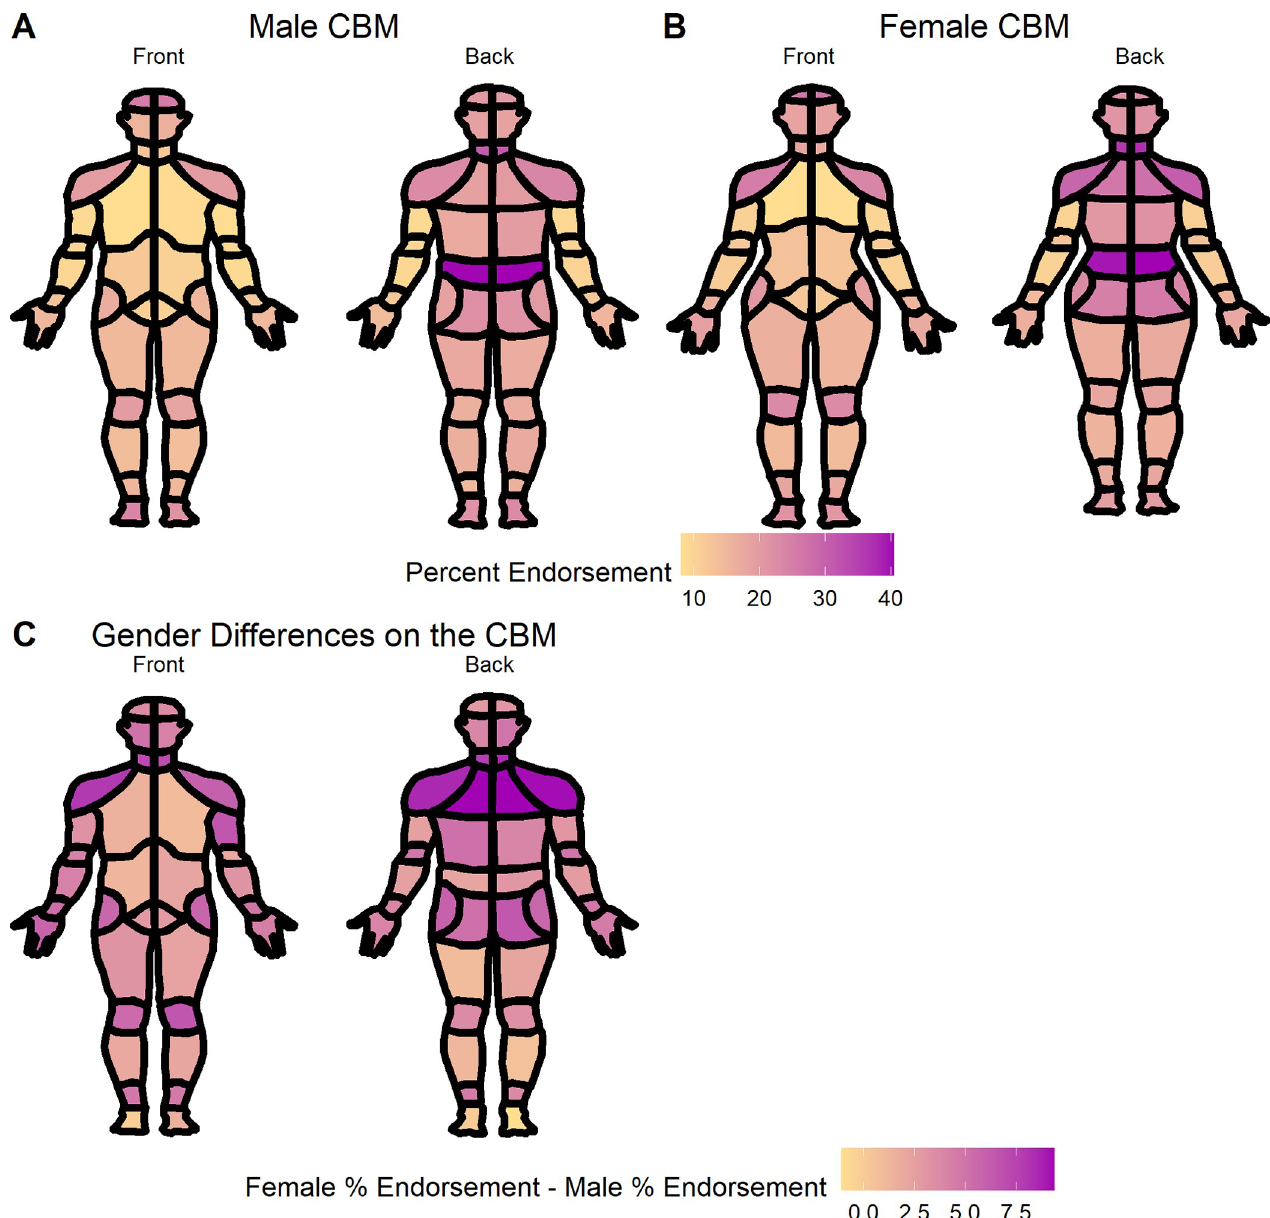
Fig 5. The (A) male and (B) female CBM with the percentage of patients who endorsed each body location. (C) The difference between the percent female endorsement of each CBM location and the percent male endorsement (subtract male endorsement from female endorsement).